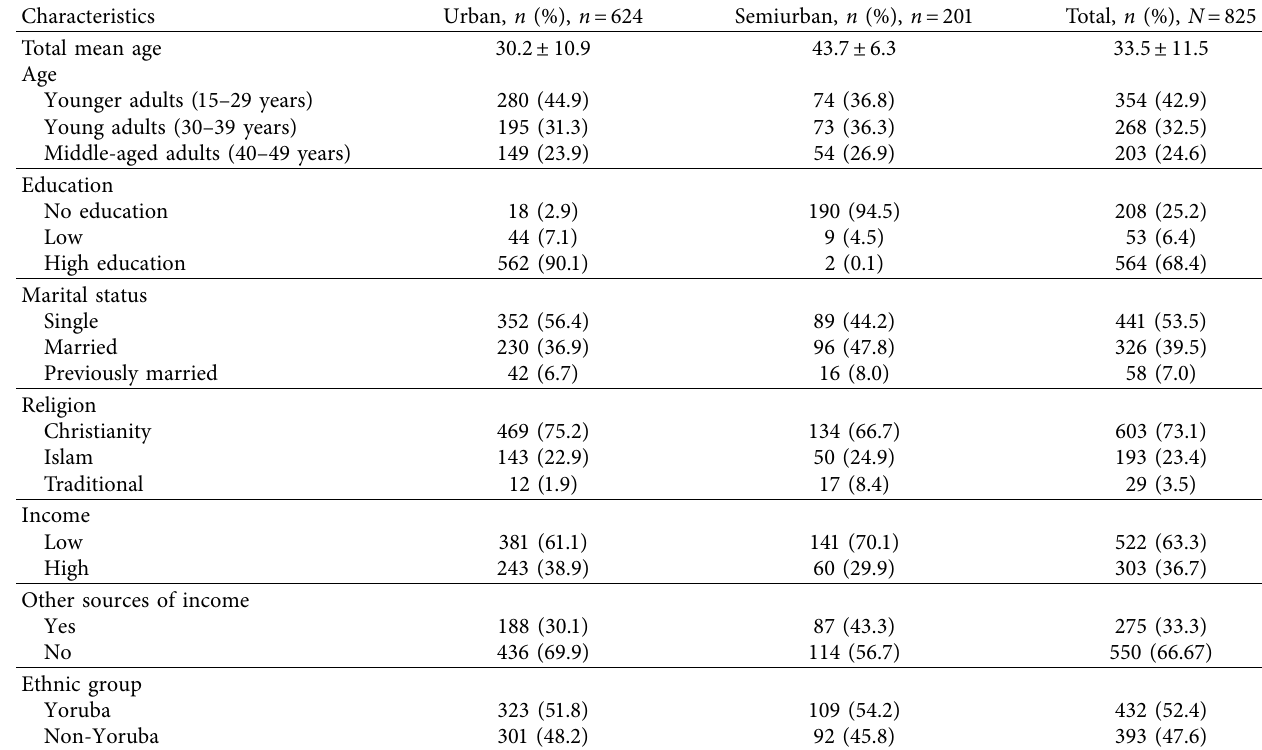
Table 1: Characteristics of study respondents.